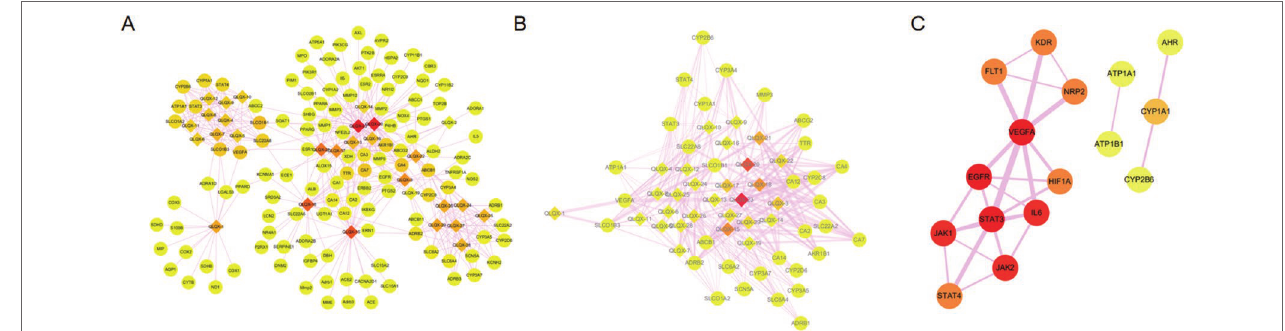
FIGURE 3 | The networks associating with QLQX in the treatment of CHF. (A) The component-target network consisted of 149 nodes and 446 edges. (B) The major hub network define by nodes with degree higher the average number of neighbors (5.830). (C) The PPI network of hub targets obtained from STRING database and constructed by Cytoscape. The ellipse nodes represent targets, and the diamond nodes represent active components in QLQX, the widths of the edges represent the order of the edge betweenness and the colors of the nodes are illustrated from red to yellow in descending order of degree